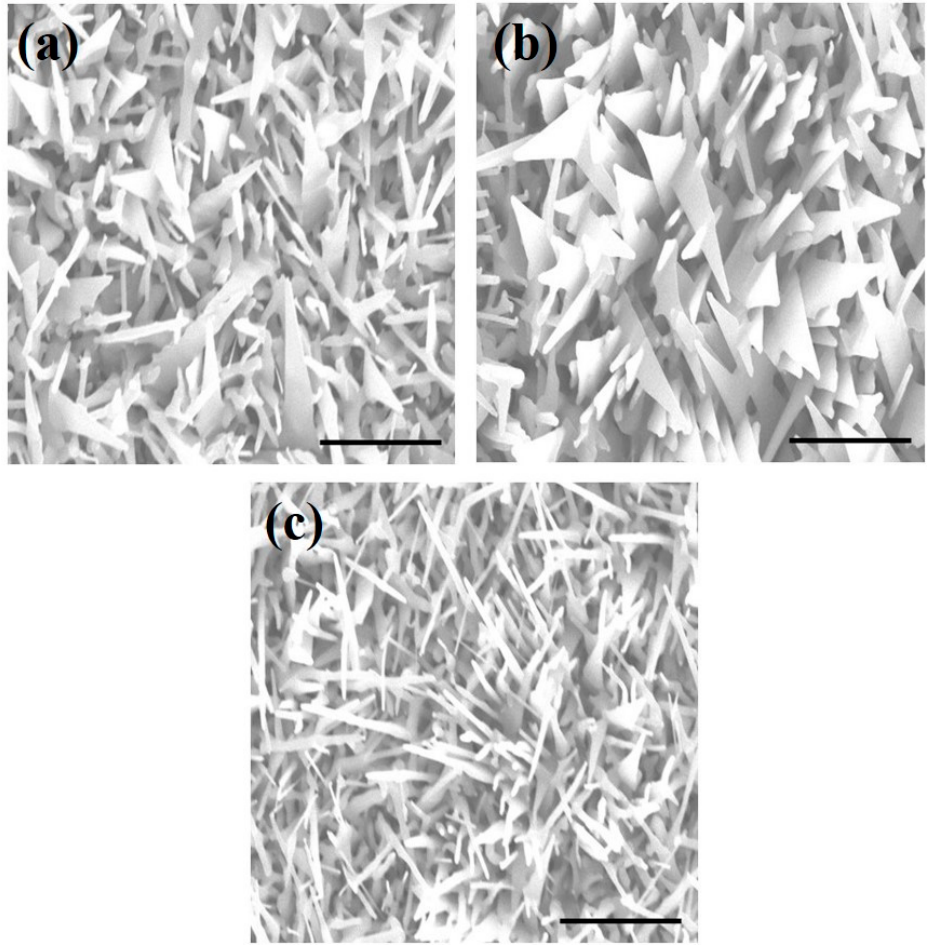
Figure 4. FE-SEM images of ZnO nanostructures grown in perpendicular setup on Au-coated Si substrates as function of growth temperature at Ar/O 2 flow rate of 120/1.0 sccm in gas mixture: ( a ) 700 ◦ C, ( b ) 800 ◦ C, and ( c ) 900 ◦ C. Scale bar is 3 µ m.